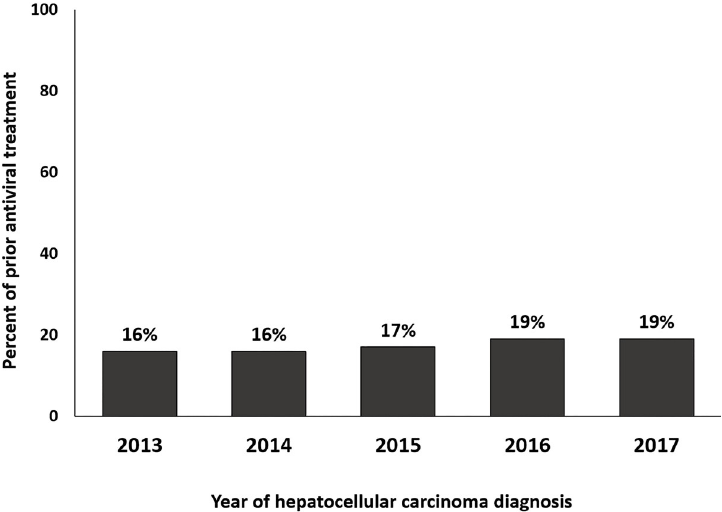
Fig 2. Proportions of patients with hepatitis C virus-related hepatocellular carcinoma in groups with and without prior hepatitis C virus treatment by year of diagnosis.